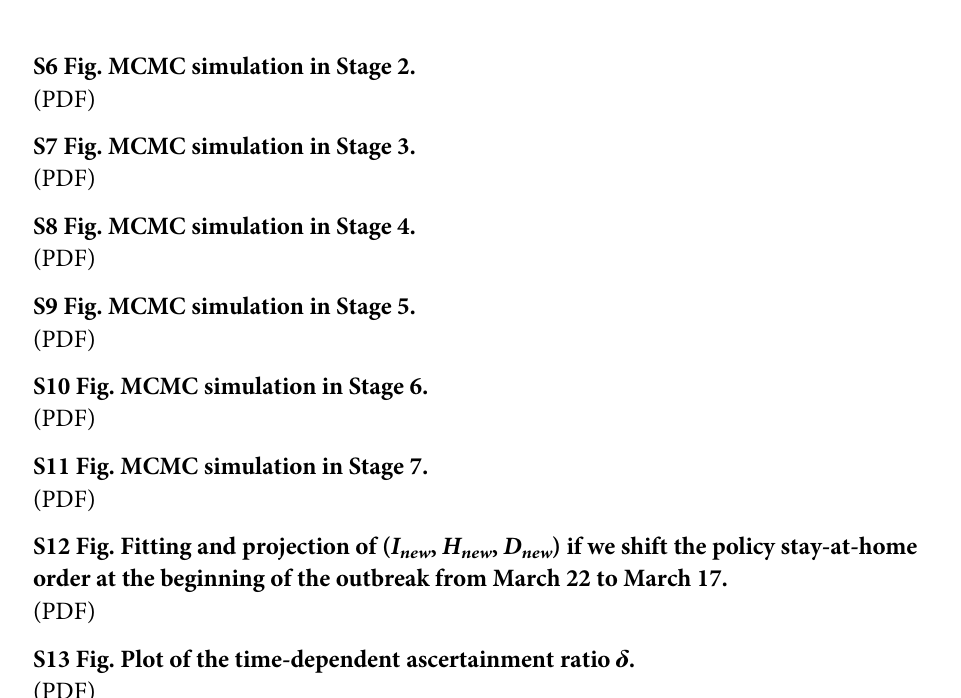
S14 Fig. Fitting and projection of ( I ratio δ . S15 Fig. Fitting and projection of ( I ratio δ and alternate initial